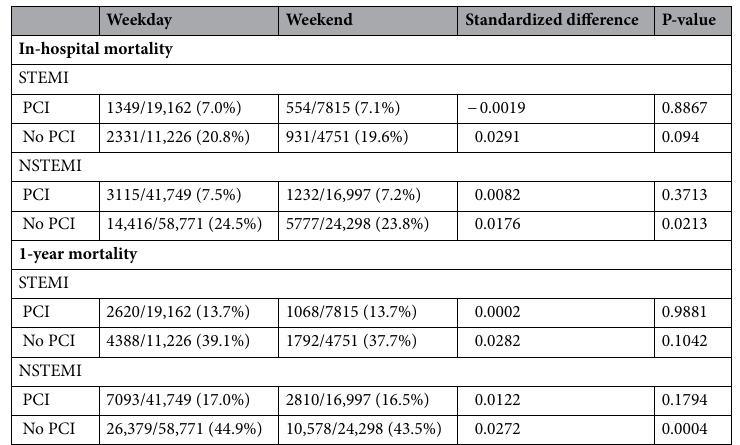
Table 1. Patient characteristics according to admission time. MI myocardial infarction, NSTEMI non-ST elevation myocardial infarction, STEMI ST elevation myocardial infarction.